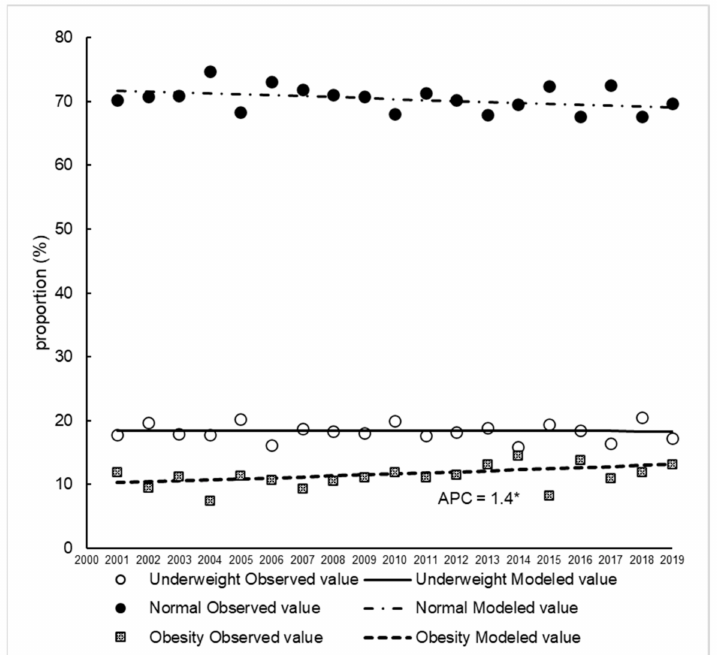
Figure 1. Trends in the proportion of young women classified as underweight, normal and obese between 2001 and 2019. Trends in the proportion of young women were analysed using Joinpoint regression analysis ( p < 0.05). APC, annual percentage change. * p <